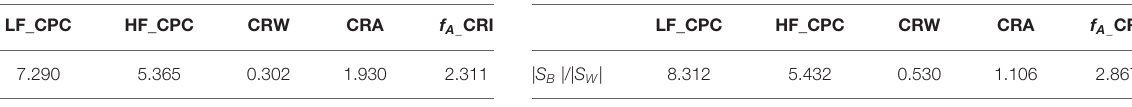
TABLE 7 | The divergence analysis of the features of CPC and CRI in the deep sleep and light sleep.